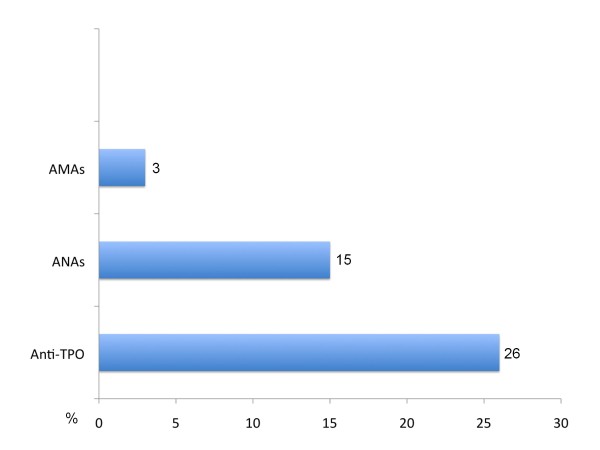
Frequency of associated auto-antibodies found in all MS patients. Anti-TPO = Anti-thyroid peroxidase antibodies; ANAs = Anti-nuclear antibodies; AMAs = Anti-mitochondrial antibodies